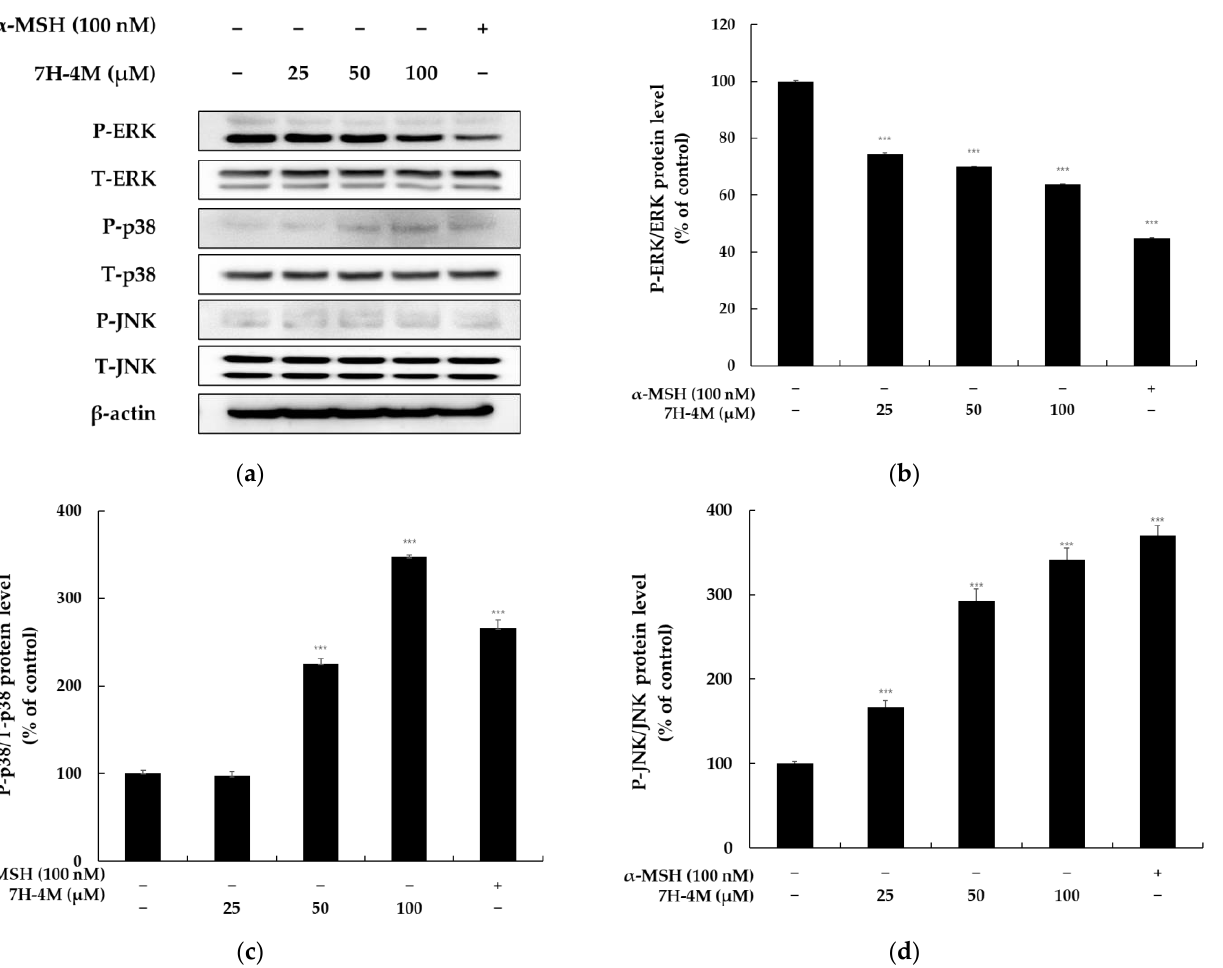
Figure 8. The effect of 7H-4M on the melanogenesis-related protein expression of B16-F10 cells. The experiment involved treating cells with various concentrations of 7H-4M for 24 h, followed by harvesting the cells. Protein extracts were prepared from each treatment group and the expressions of MAPKs (P-ERK, P-p38, and P-JNK) were evaluated. The relative intensity of the protein band was quantified using ImageJ software and the value was normalized to that of the corresponding loading control. Untreated cells were used as the control group and were considered to have a value of 100%. ( a ) Western blotting results and ( b ) P-ERK, ( c ) P-p38, and ( d ) P-JNK protein expression. The results were shown as the mean ± SD of at least three independent experiments, with statistical significance indicated by *** p < 0.001.